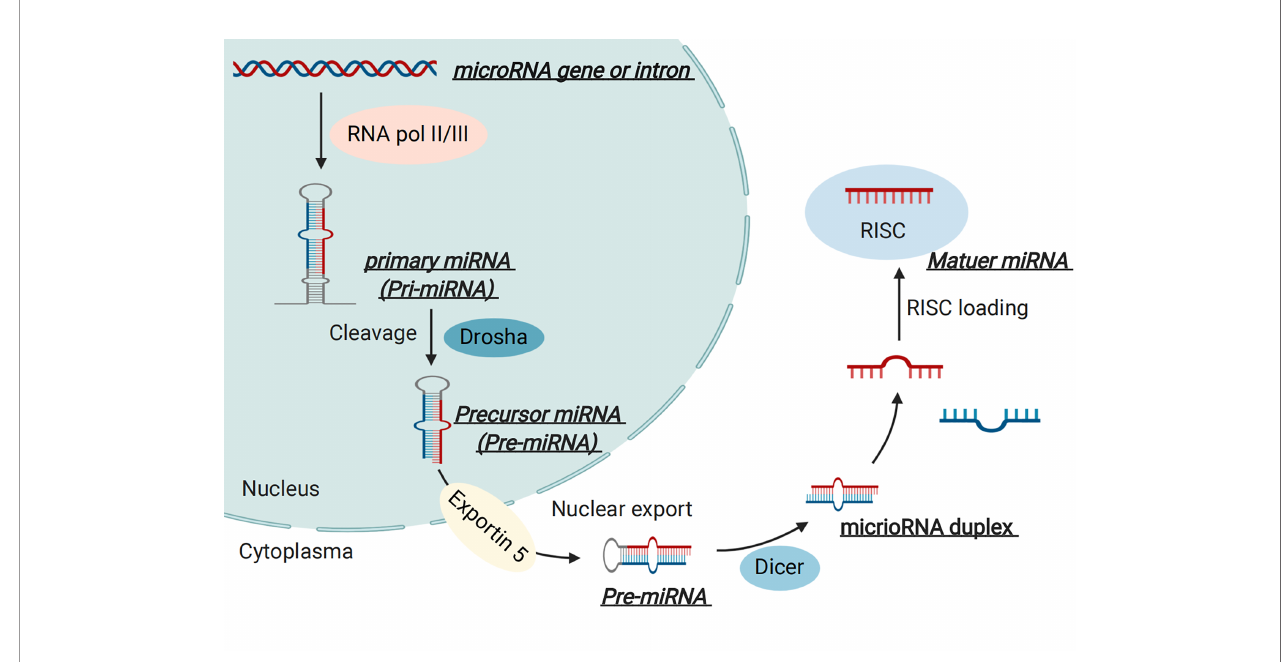
FIGURE 2 | MicroRNA (miRNA)